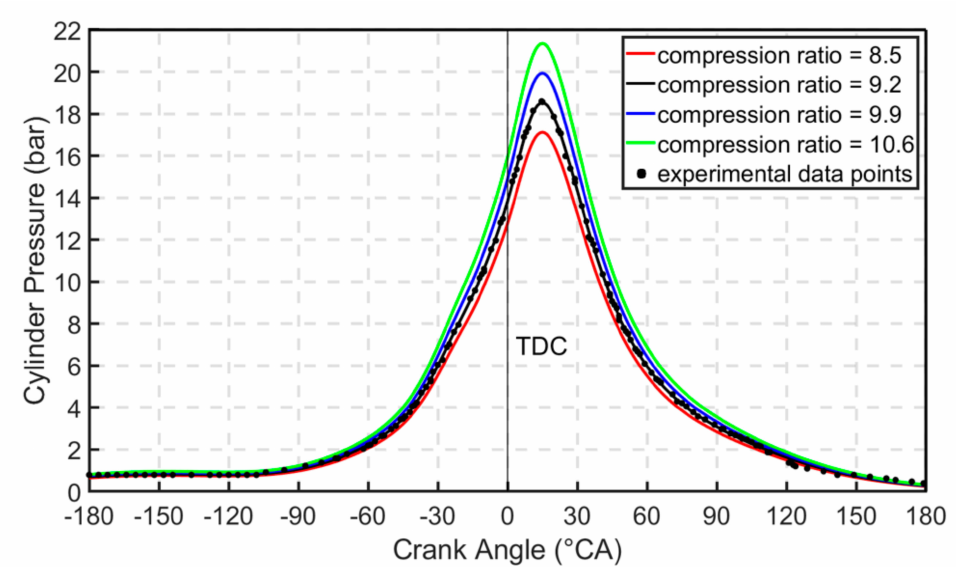
Figure 21. Comparison between cylinder curves with di ff erent compression ratios (minimum